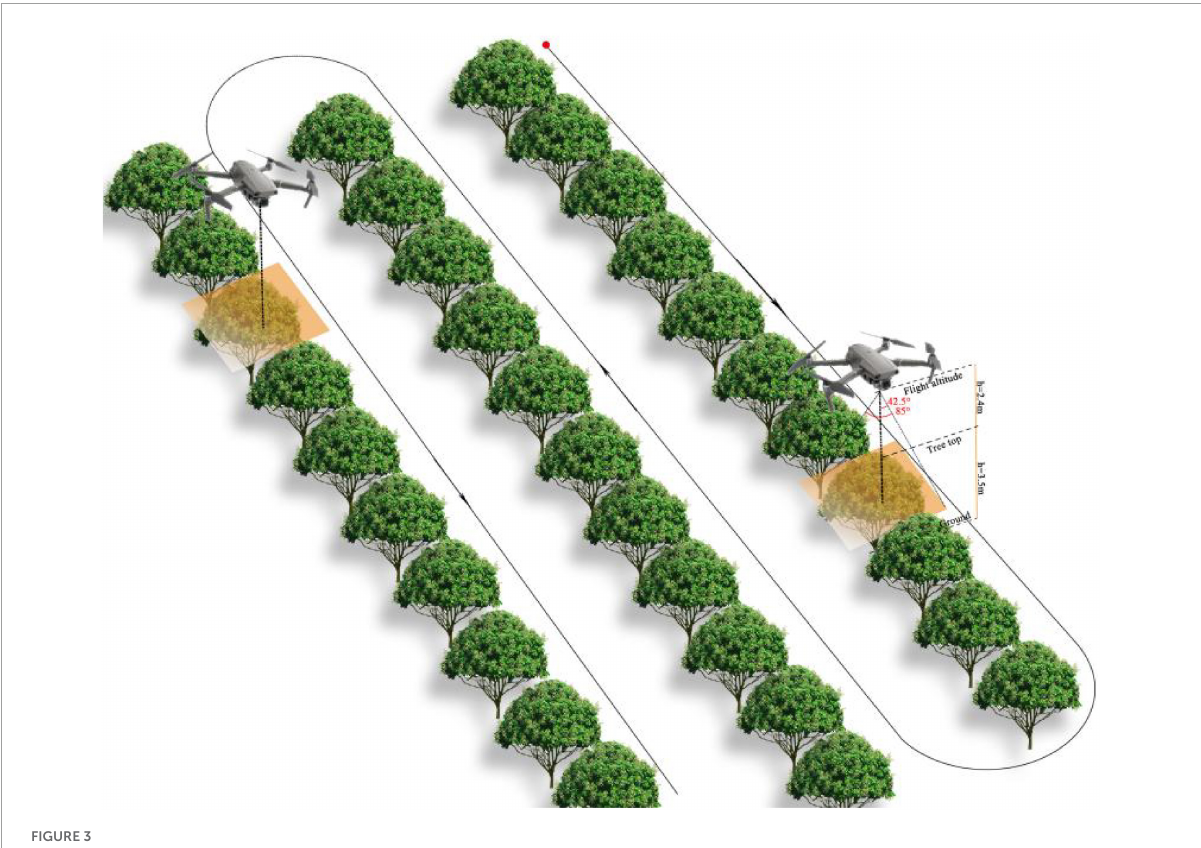
FIGURE3 Image acquisition